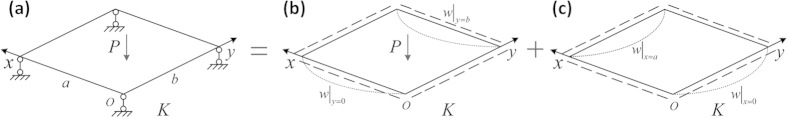
Symplectic superposition for static bending problem of a rectangular thin foundation plate with four corners point-supported.